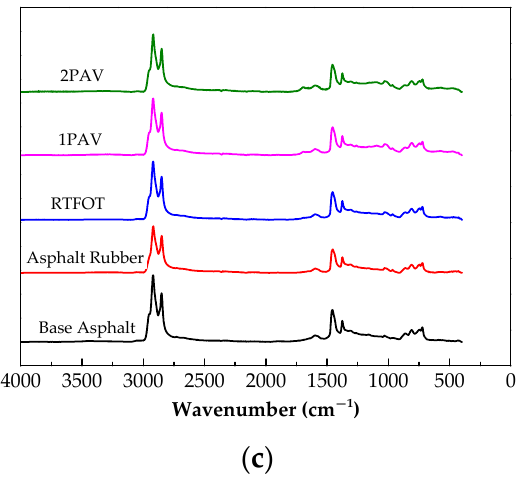
Figure 9. FTIR spectra of asphalt rubbers for different aging levels. ( a ) 1#; ( b ) 2#; ( c ) 3#.